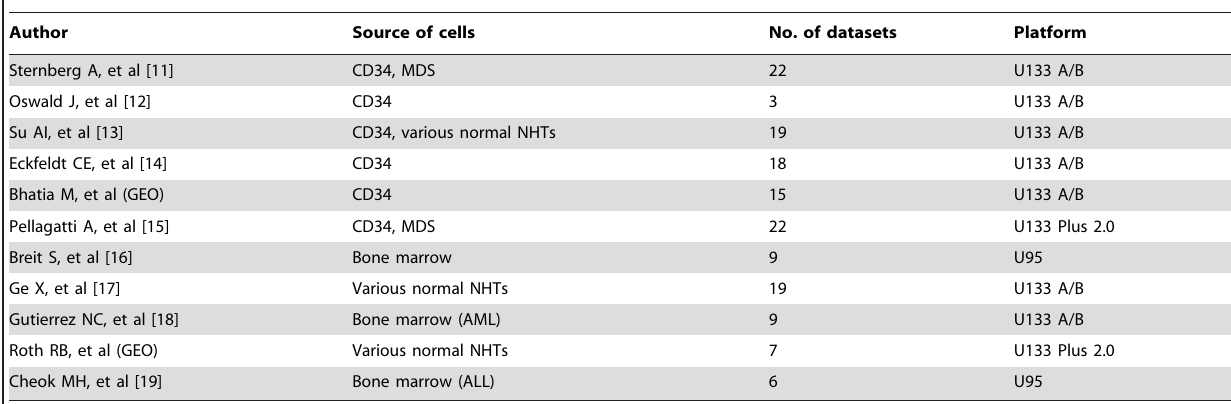
Table 1. Sources of data for the